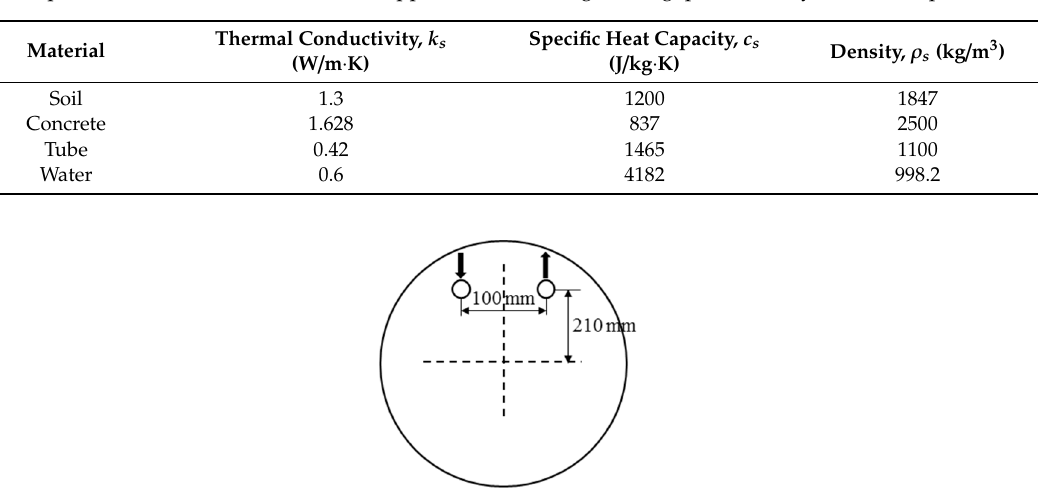
Figure 1. Schematics of the energy pile group embedded with a deeply penetrating U-shaped heat exchanger.